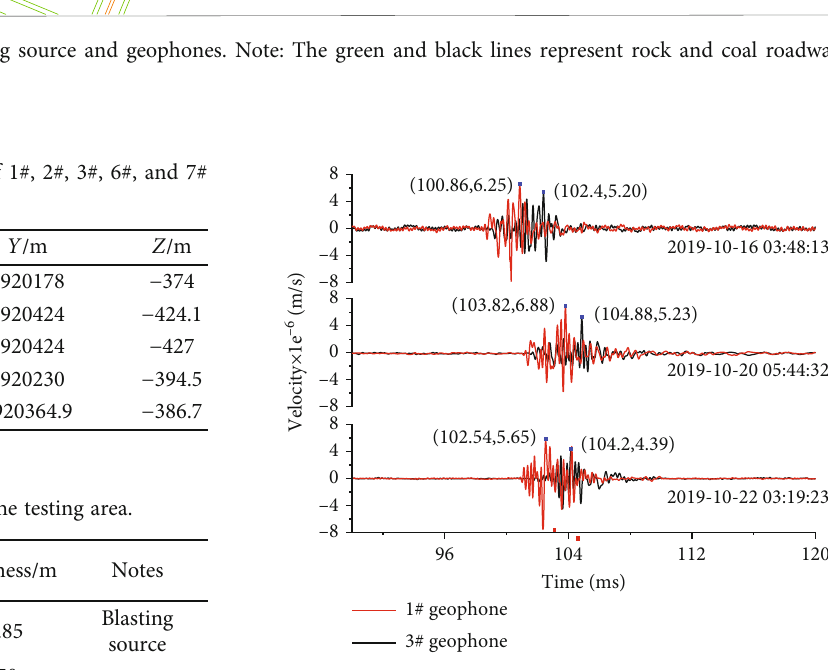
Figure 16: Waveforms of P-waves monitored by #1 and #3